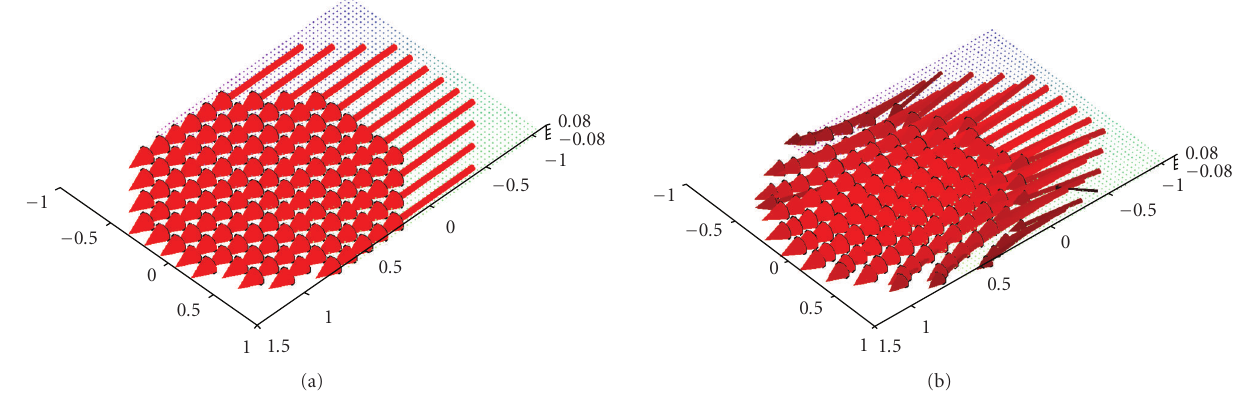
Figure 8: (a) Original vector field f ( x ) = (1,0,0) (cid:9) . (b) Reconstruction with the described algorithm for γ = 0 . 0075 using exact, simulated data D 1 f